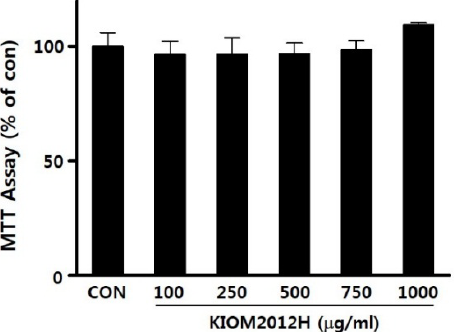
Figure 2. Effect of KIOM2012H on HepG2 cell viability treated with different concentrations of KIOM2012H for 24 h. Data represent mean ± SE of three independent experiments for